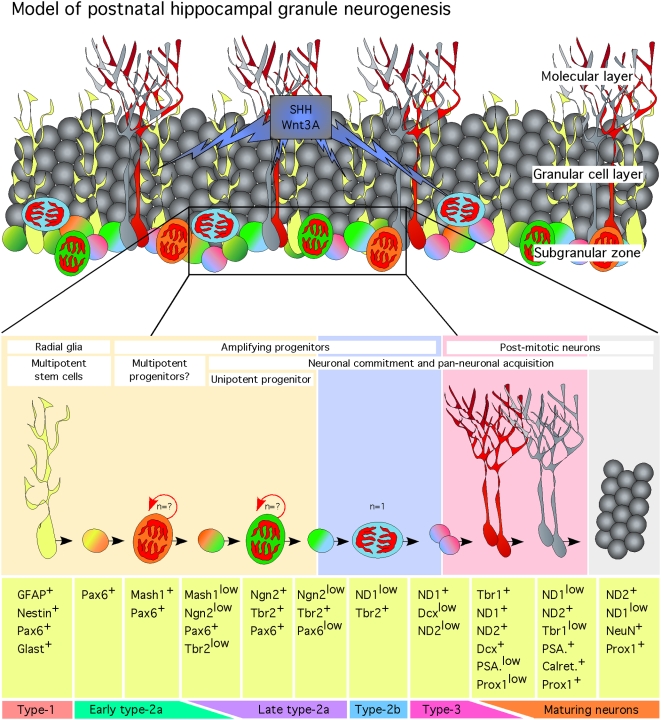
Model of postnatal hippocampal granule neurogenesis.Multipotent GFAP/Nestin/Pax6/Glast+ radial glia stem cells give rise to multipotent and highly dividing Pax6/Mash1+ progenitors. Ngn2 initiates neuronal commitment of Pax6/Mash1+ progenitors. Ngn2 progenies undergo asymmetric divisions and amplify until they divide symmetrically and express NeuroD1. NeuroD1 stops the amplification phase of Ngn2 progenies and direct neuronal maturation. NeuroD1 progenies undergo maturation through the expression of the transcription factors Tbr1, NeuroD2 and Prox1 and the cellular markers Dcx, PSA-NCAM, Calretinin and NeuN.